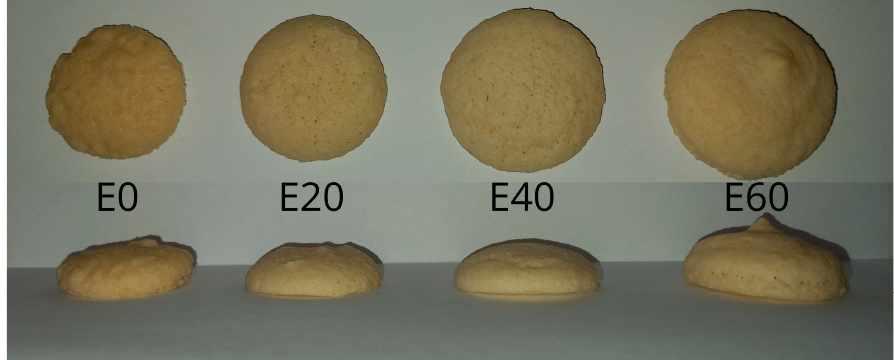
Figure 4. Images of the top views and side pro fi les of the obtained macarons.